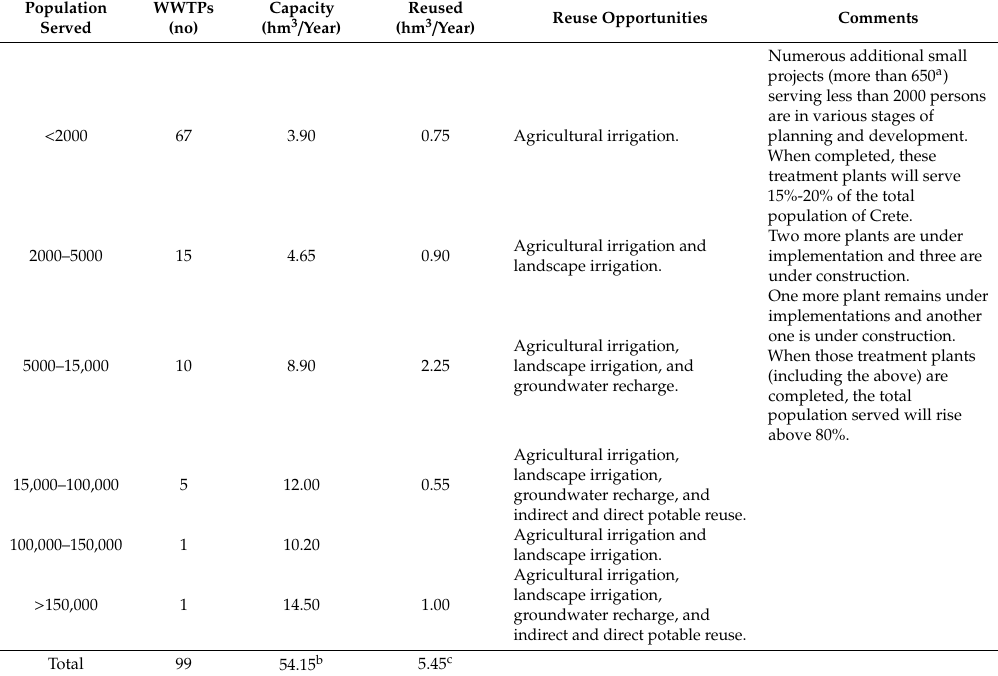
Table 9. Current status of wastewater treatment in Crete (adapted from region of Crete) [104]. Population